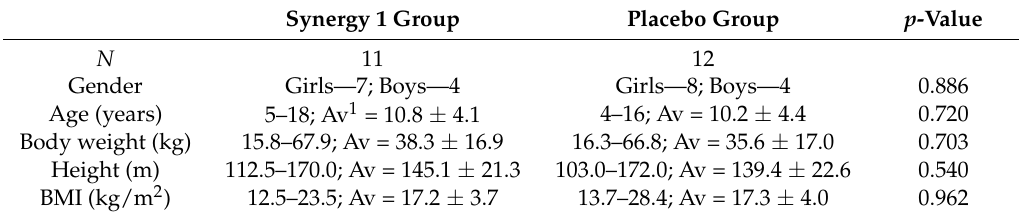
Table 2. The participants’ anthropometric data. Results are presented as ranges and means ± standard